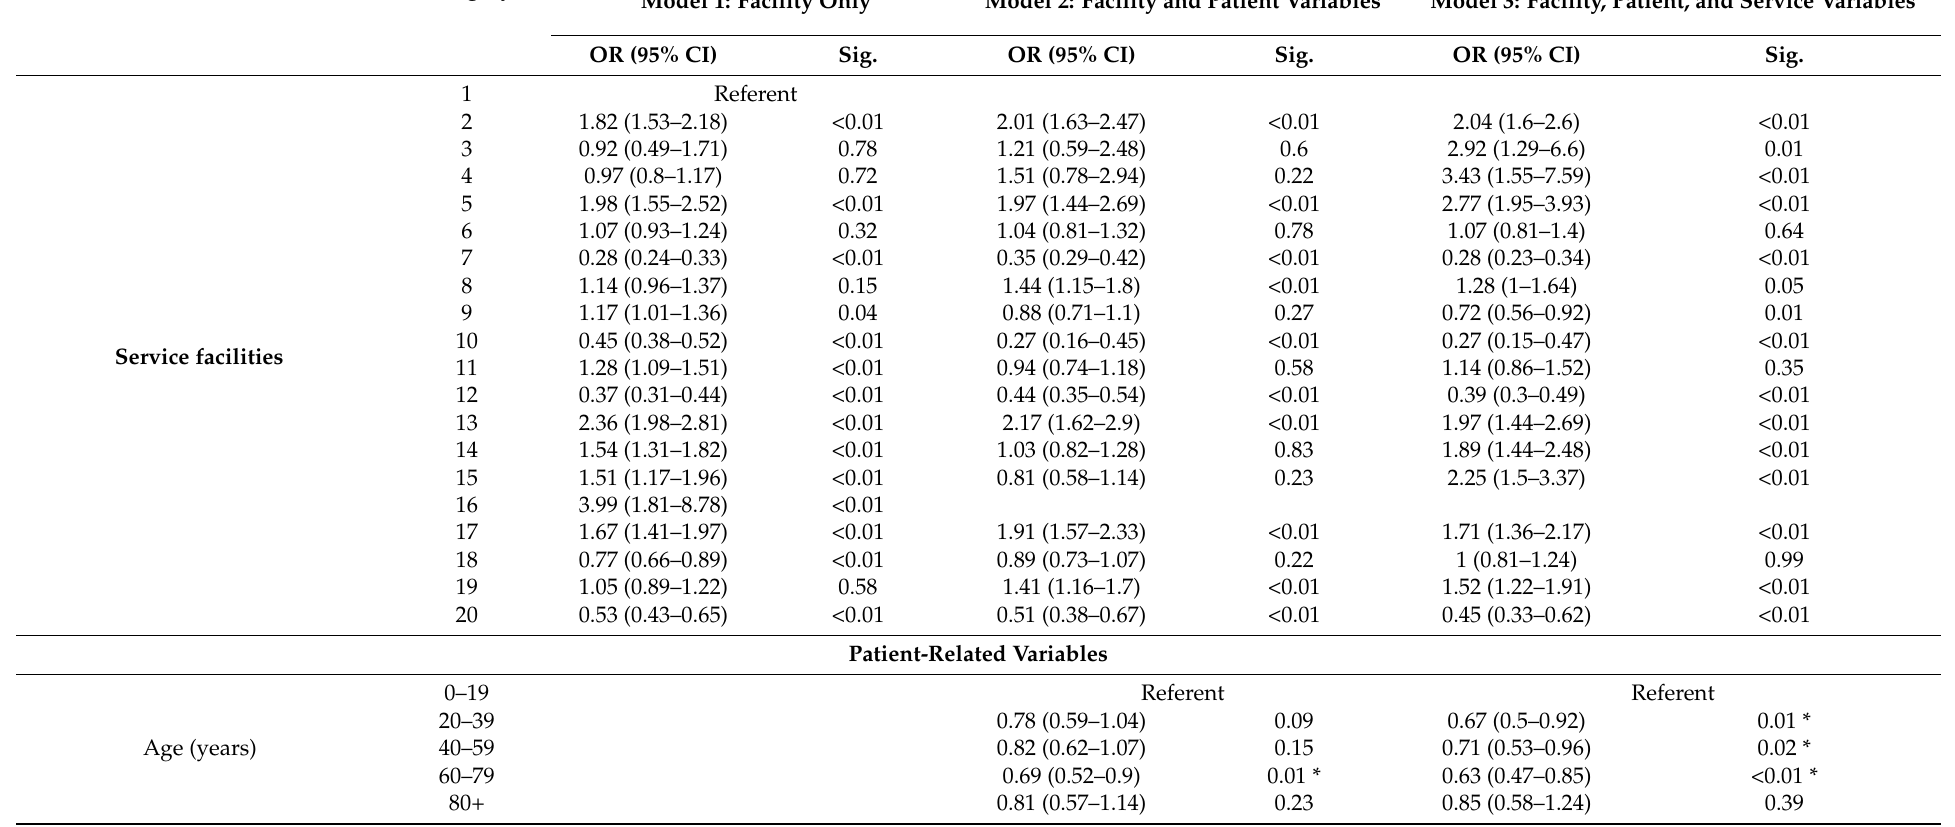
Table 4. Three hierarchical binomial regression models for the primary service outcome (Discharged) evaluating the relationship between the discharge pathway and Neurosurgical and Orthopaedic Physiotherapy Screening Clinic and Multi-disciplinary Service (N/OPSC & MDS) facility only (Model 1), adjusted for the patient-related variables (Model 2), and adjusted for the service-related variables (Model 3). Significant service variables in the final model included management duration, triage category, nonattendance, and medical specialist input. Shaded cells represent sites with significant variance from the referent facility (Facility 1). OR: adds